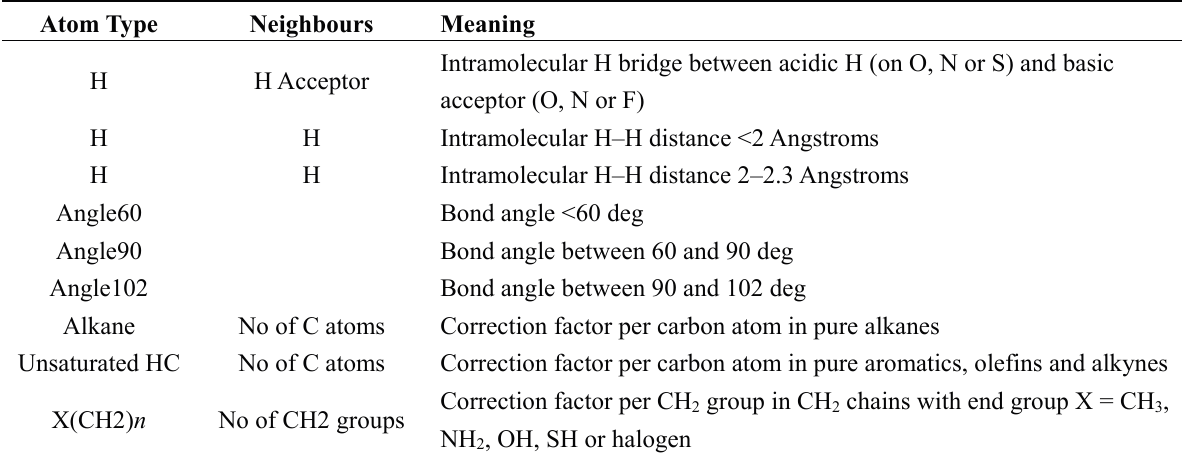
Table 2. Special Groups and their